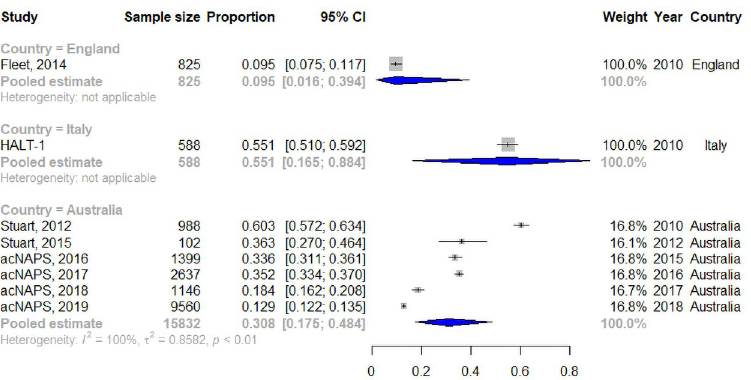
Fig 3. Meta-analysis by region of the percent of appropriate prescriptions according to McGeer criteria. CI is confidence interval. Markers for individual studies are proportional to the studies’ weight in generating the region